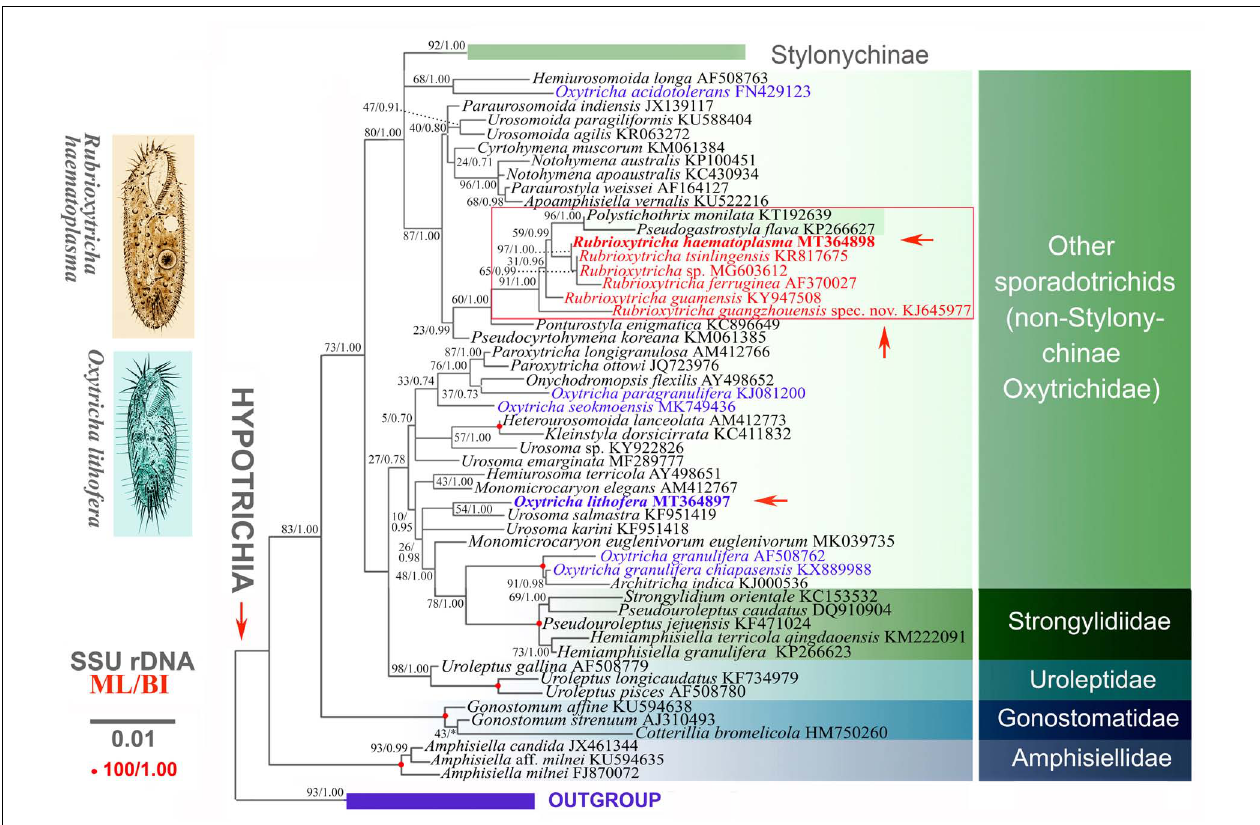
FIGURE 8 | Maximum likelihood (ML) phylogenetic tree inferred from the 18S rRNA gene sequences. Numbers near nodes represent the ML bootstrap values and Bayesian posterior probabilities. Nodes designated by an asterisk correspond to the supports not recovered in the estimated BI tree. For both trees, the scale bar corresponds to 0.01 expected substitutions per site. New sequences provided in the present work are indicated in